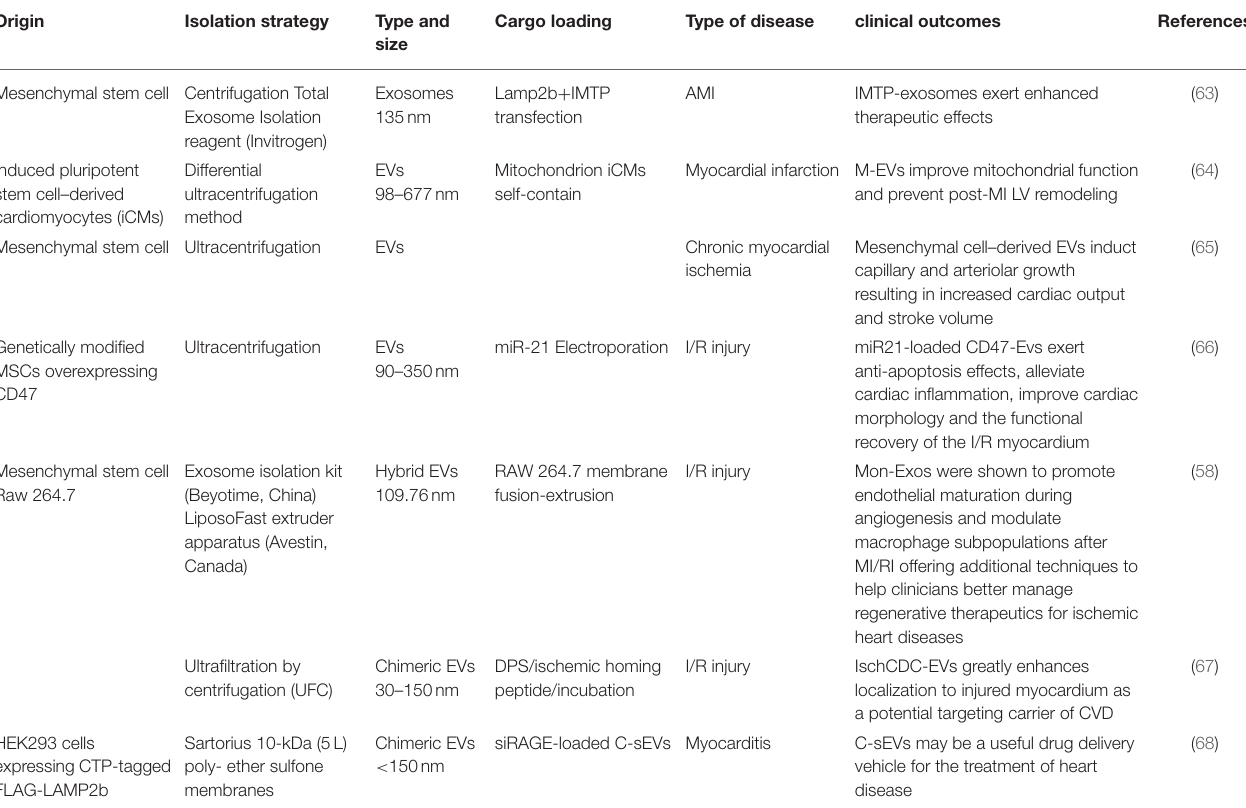
TABLE 1 | Summary of application of extracellular vesicles (EVs) as carriers in myocardial